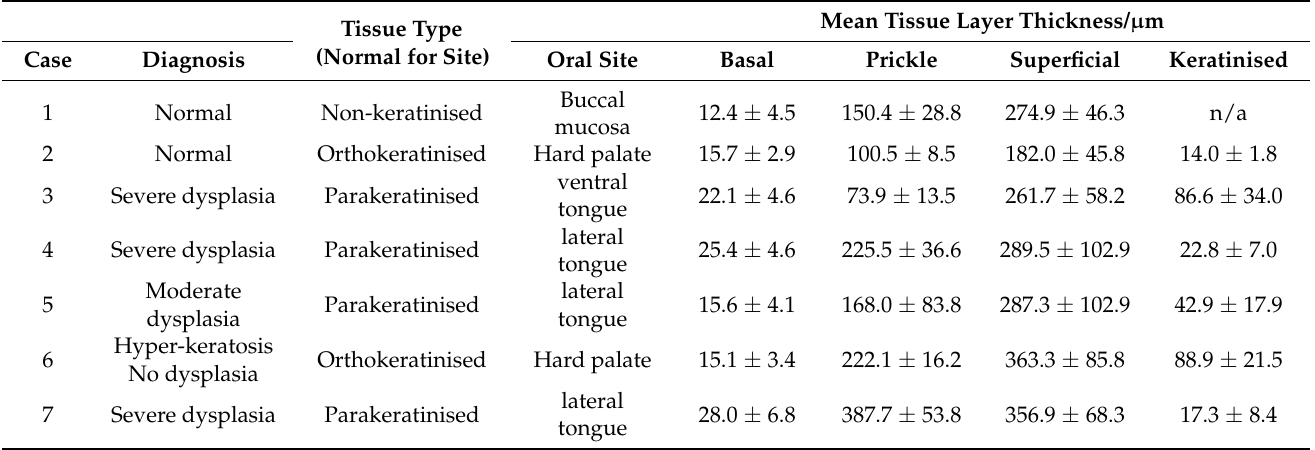
Table 1. List of all measurements used in the tissue scale models, as obtained from histological analysis or oral tissues. Moderate and severe dysplasia are forms of